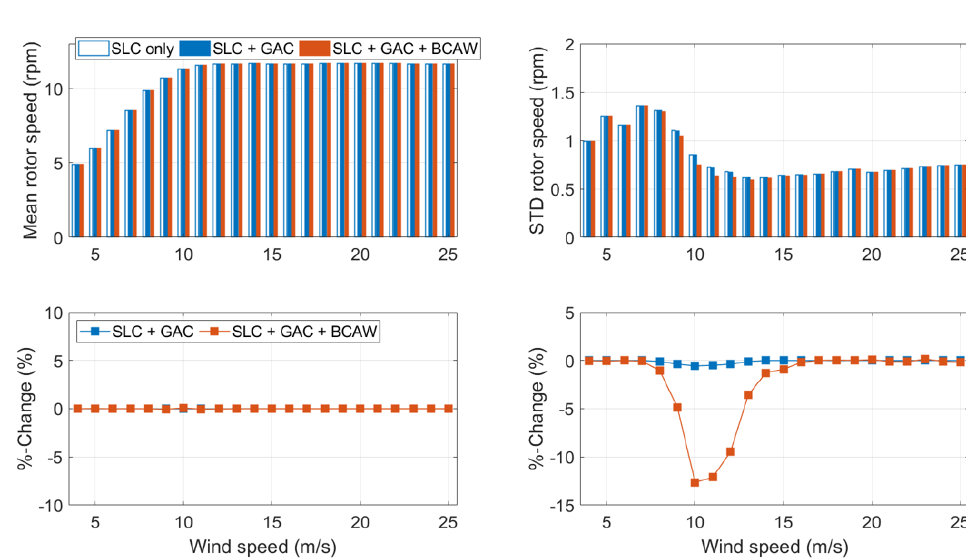
Figure A2. Variation of the mean and standard deviation of the rotor speed from cut-in to cut-out wind speed under DLC 1.2 with different control architectures. Top—Dimensional values; Bottom— Percentage changes with respect to the ‘SLC Only’ case.